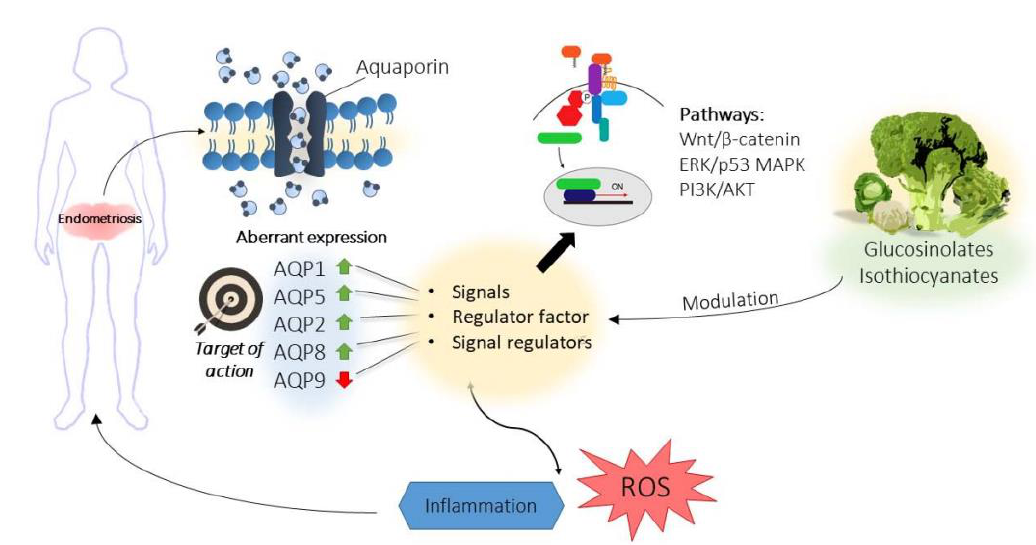
Figure 2. Role of aquaporins in endometriosis. Aquaporins are involved in different signaling pathways related with inflammation and endometriosis. Besides, aquaporins present an aberrant expression in endometrial tissues of women with endometriosis and therefore, they could be the target of therapies based on bioactive compounds derived from brassicas.